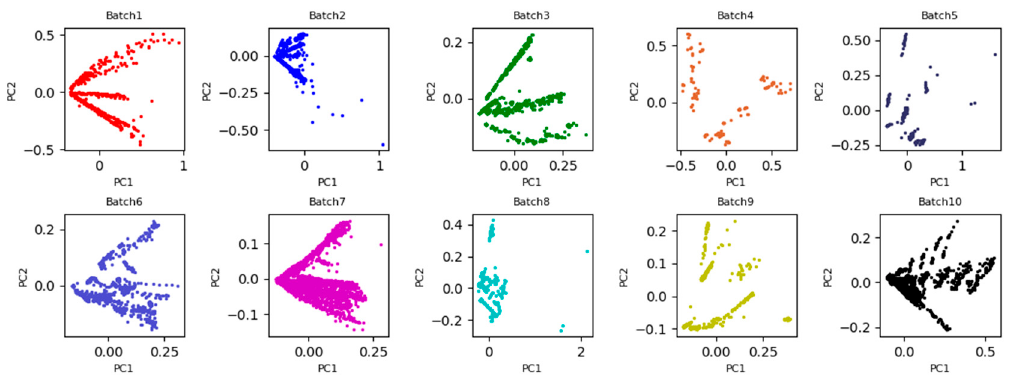
Figure 2. Two-dimensional principle component (PC1, PC2) scatter points of 10 batches data by principal component analysis (PCA).